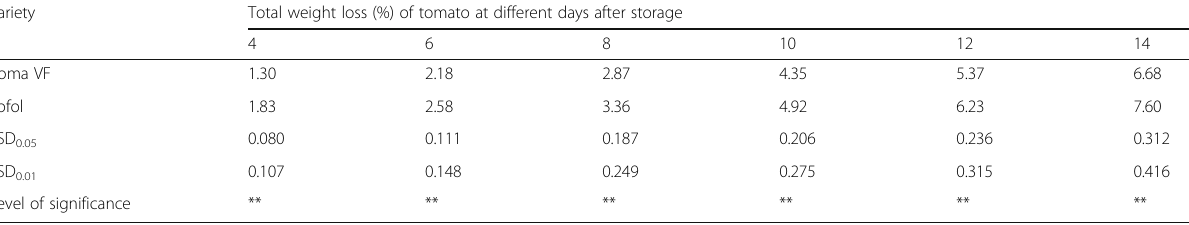
Table 5 Effects of varieties on total weight loss of tomato during storage and ripening Variety Total weight loss (%) of tomato at different days after